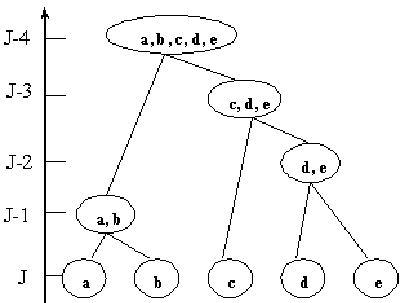
Figure 1. Schematics of the excitation wavelengths clustering. Initially there are J excitation wavelength classes.